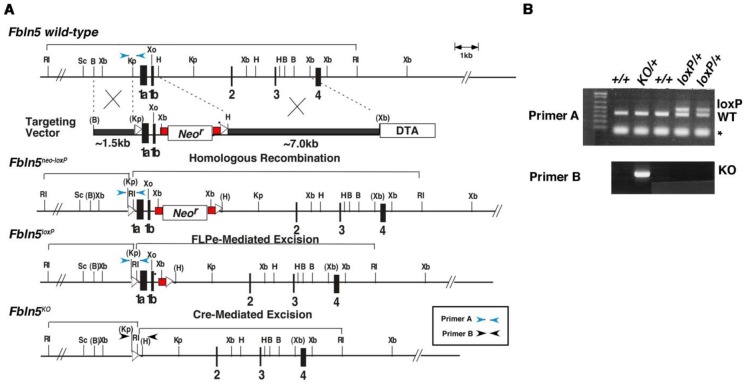
Expression of Fbln5 and urea-extractable soluble tropoelastin (TE) in tissues as a function of development in rats.Quantitative amounts of Fbln5 (PANEL A) and extracted tropoelastin (B) normalized to coomassie-stained protein in aorta, lung, vagina, and skin. Data represent mean ± SEM of 3–4 tissues in each group. RU, Relative Units, E20, embryonic day 20, P1, postnatal day 1; P5, postnatal day 5 *p<0.05 ANOVA with Dunnett’s post hoc testing with E20 as the control